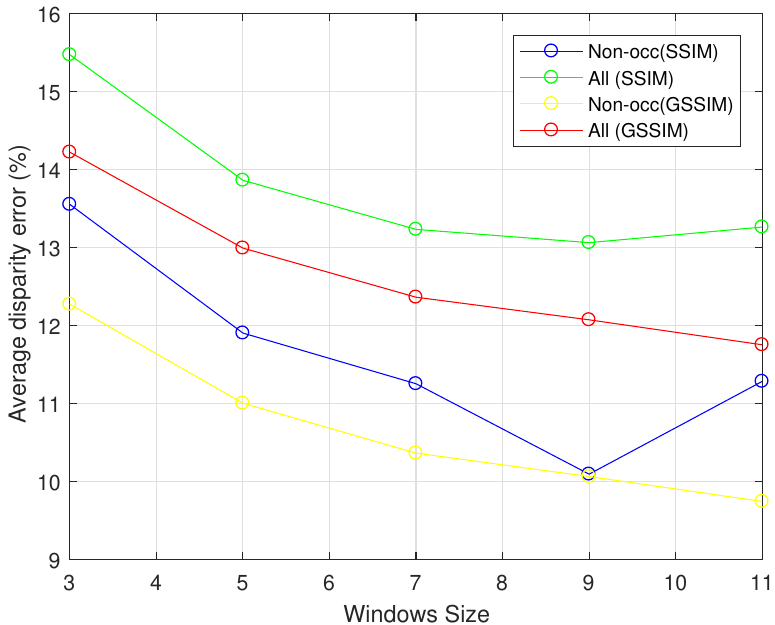
Figure 2. The disparity results obtained with respect to support window size for both cost functions, for KITTI 2012 training sets. Table 3. Percentage of erroneous disparities in non-occluded and regions for the KITTI 2012 training set. Cost functions 2 px Threshold 3 px Threshold 5 px Threshold Non-Occluded All Non-Occluded All Non-Occluded